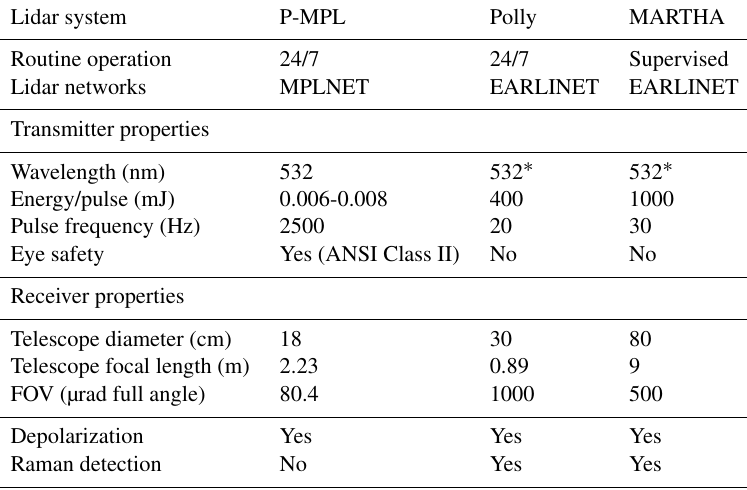
Table 1. Main instrumental features of the lidar